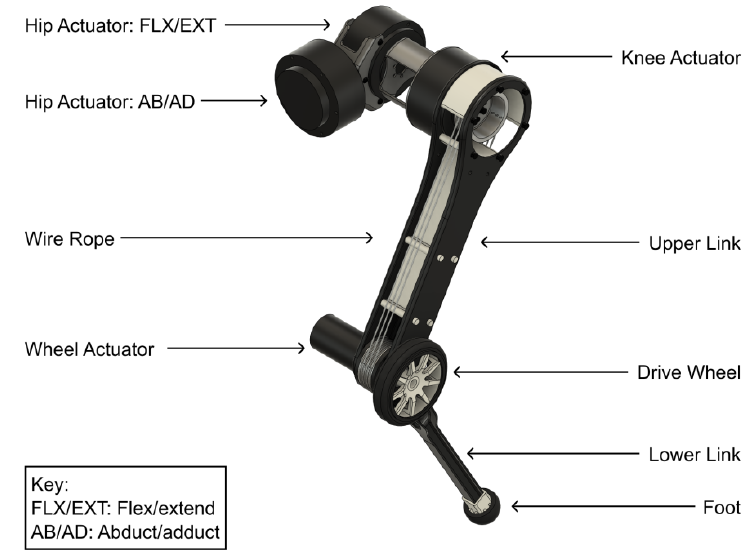
Figure 3. The designed structure of a robot leg.